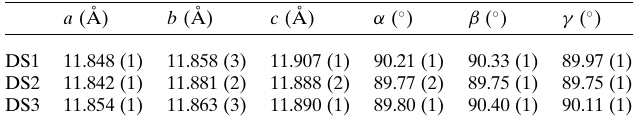
Table 6 Lattice parameters from unconstrained refinement with distortion compensation obtained from known unit-cell constraint.